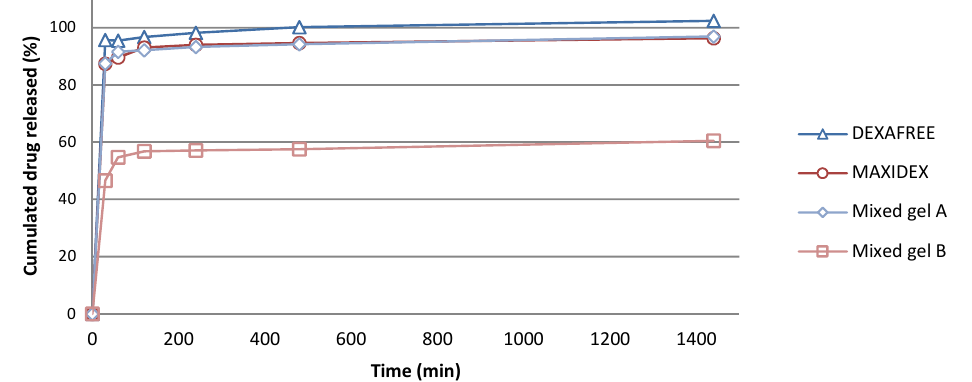
Figure 7. In vitro drug release from MAXIDEX ® , DEXAFREE ® and optimized mixed gels A and B in PBS, at 35 °C.